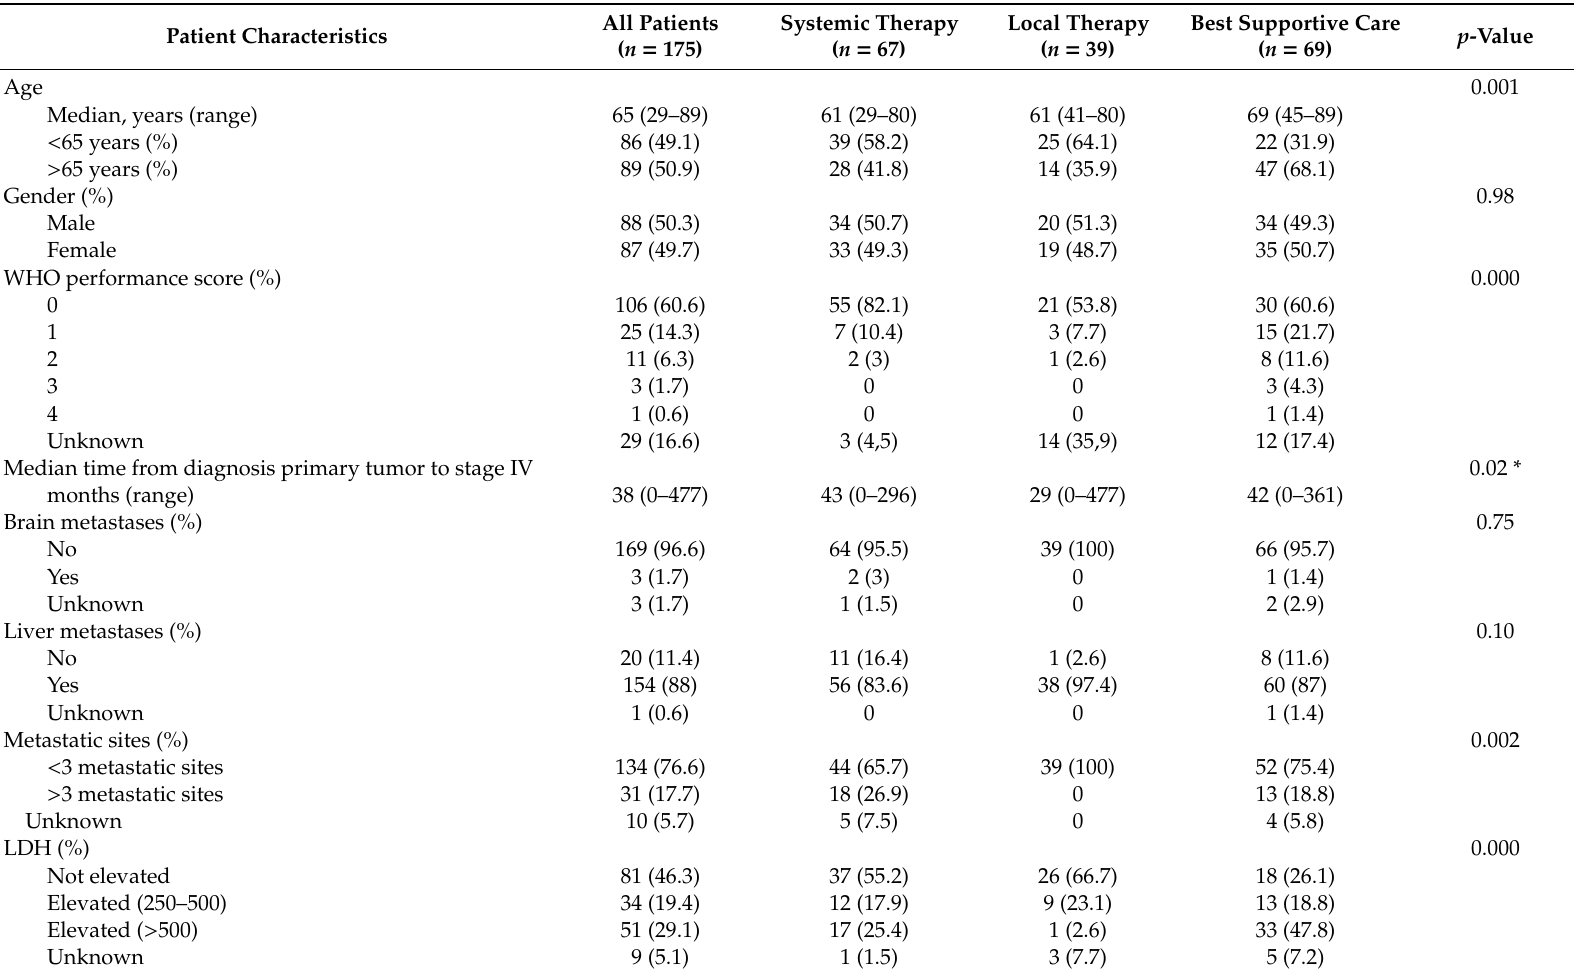
Table 1. Patient characteristics at the moment of diagnosis with metastatic